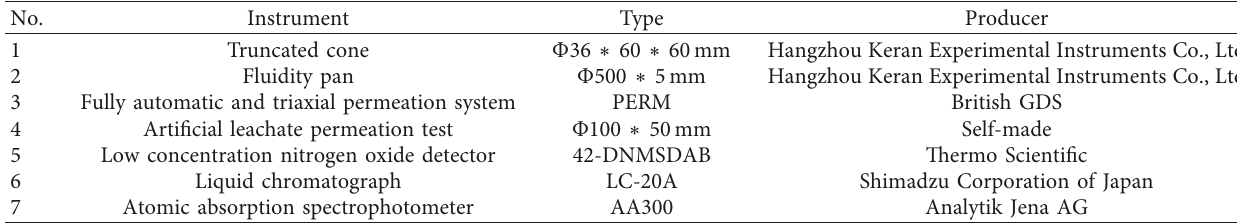
Table 6: Details of testing